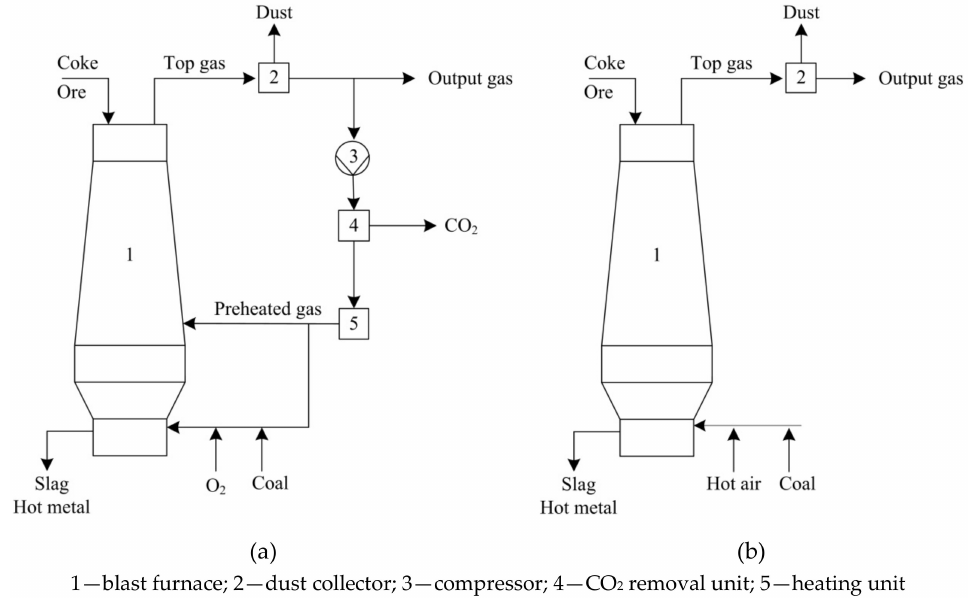
Figure 1. Schematic diagrams of ( a ) oxygen blast furnace with top gas recycling (TGR-OBF) and ( b ) traditional blast furnace